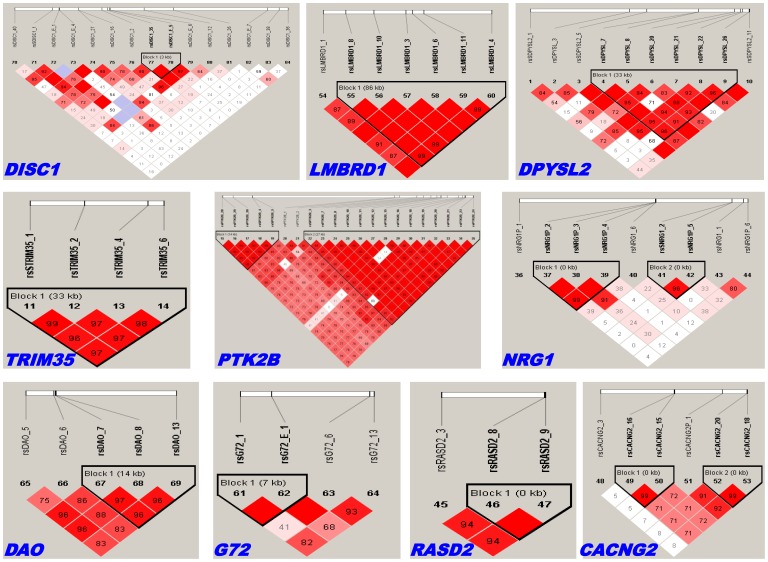
The LD structures of 84 SNPs in 10 candidate genes for vulnerability to schizophrenia.For each gene, the id of each SNP in the gene is listed, and the locations reflect the relative physical positions of the SNPs (in units of base pairs). The LD coefficient, D’, is provided unless D’ = 1. The color scheme for D’ presentation is as follows: white depicts the case of D’ <1 and LOD <2; blue depicts the case of D’ = 1 and LOD <2; pink or light red depicts the case of D’ <1 and LOD ≥2; bright red depicts the case of D’ = 1 and LOD ≥2. The LD block(s) within each gene is marked by an inverted triangle based on Gabriel’s method [81].